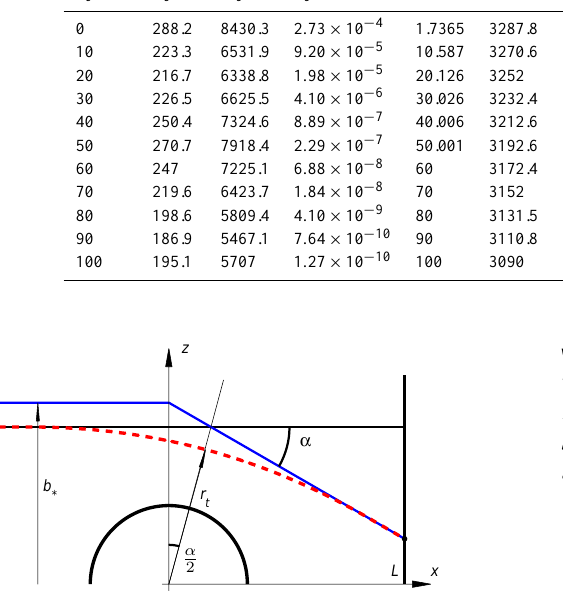
Figure 1. The phase screen approximation: the atmosphere acts as a refraction plane where the total refraction angle α is acquired at x = 0. For small angles, negligible errors are introduced for the impact parameter b and the geolocation of the remotely sensed